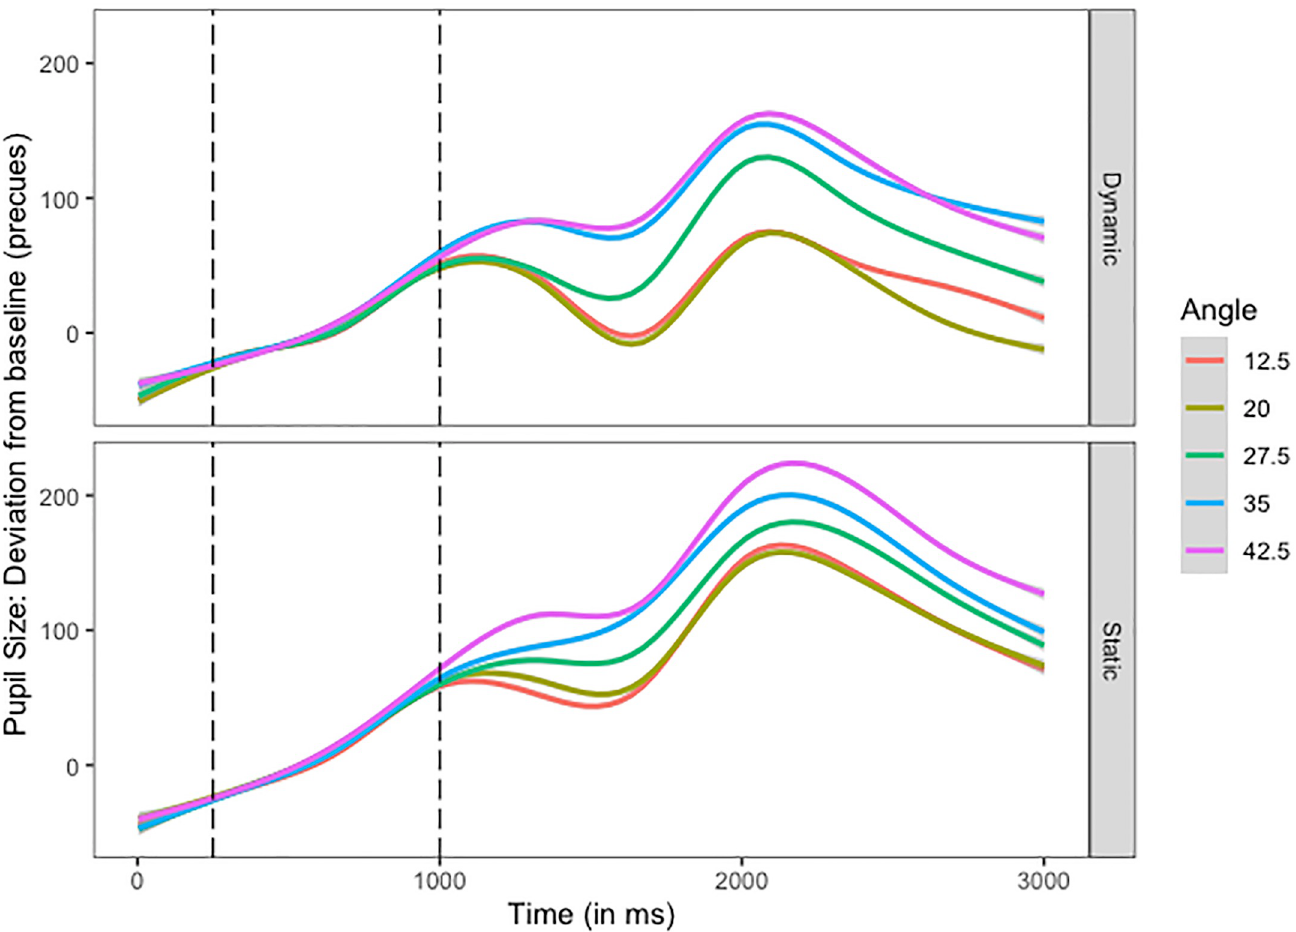
Fig 3. Timeline of the mean pupil size deviations (in arbitrary units) from the baseline per angle, in number of pixels starting at the beginning of a trial (cf. Fig 1). Each angle is represented as a separate line. The dashed vertical lines represent the onsets of the pre-cues and the measurement phase, respectively.